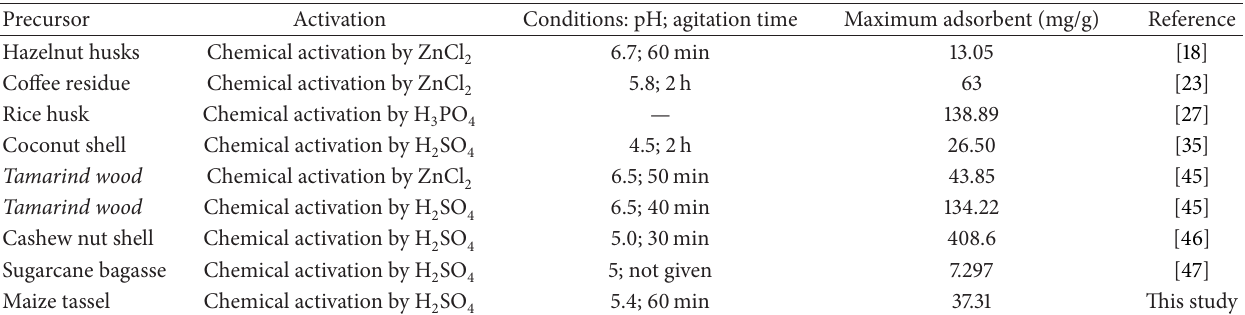
Figure 6: (a) Freundlich isotherm for Pb(II) ion adsorption using activated carbon (b) Langmuir isotherm for Pb(II) adsorption using activated carbon (10mg/L, pH = 5.4, and dosage = 1.2g). Table 3: Performance of activated carbons from various precursors for adsorption of Pb(II) from aqueous solutions.